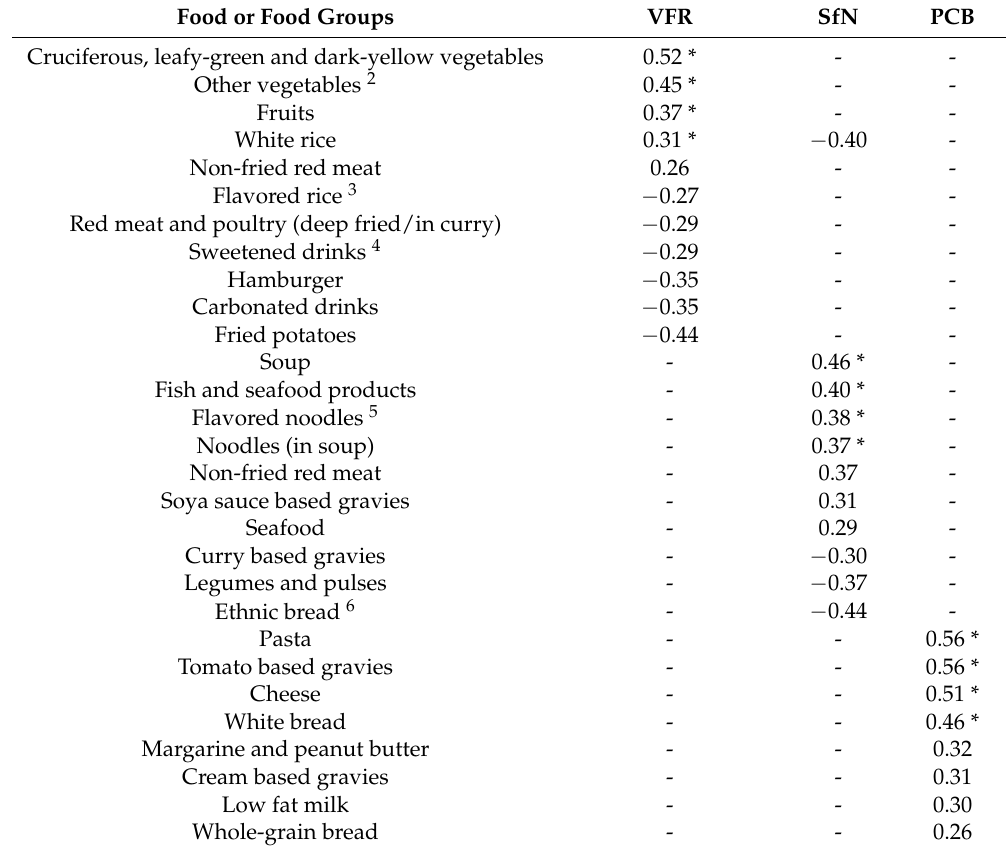
Table 1. Factor loadings for the maternal dietary patterns during pregnancy 1 . Food or Food Groups VFR SfN PCB Cruciferous, leafy-green and dark-yellow